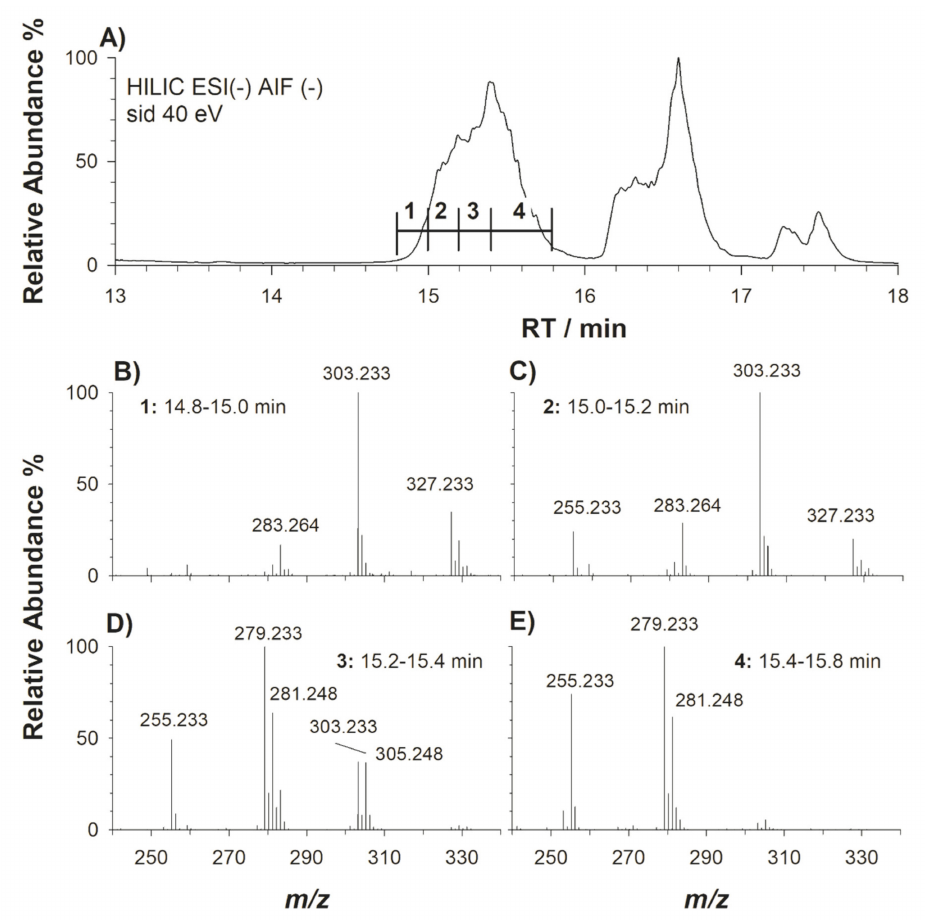
Figure 5. ( A ) Enlargement of the retention time interval where PC were eluted during the HILIC-ESI-FTMS analysis of a plasma sample lipid extract in negative ion mode. ( B – E ) AIF MS spectra averaged in the four retention time intervals selected for the PC band. As expected, PC bearing shorter (and then less hydrophobic) acyl fatty chains were more retained in the HILIC